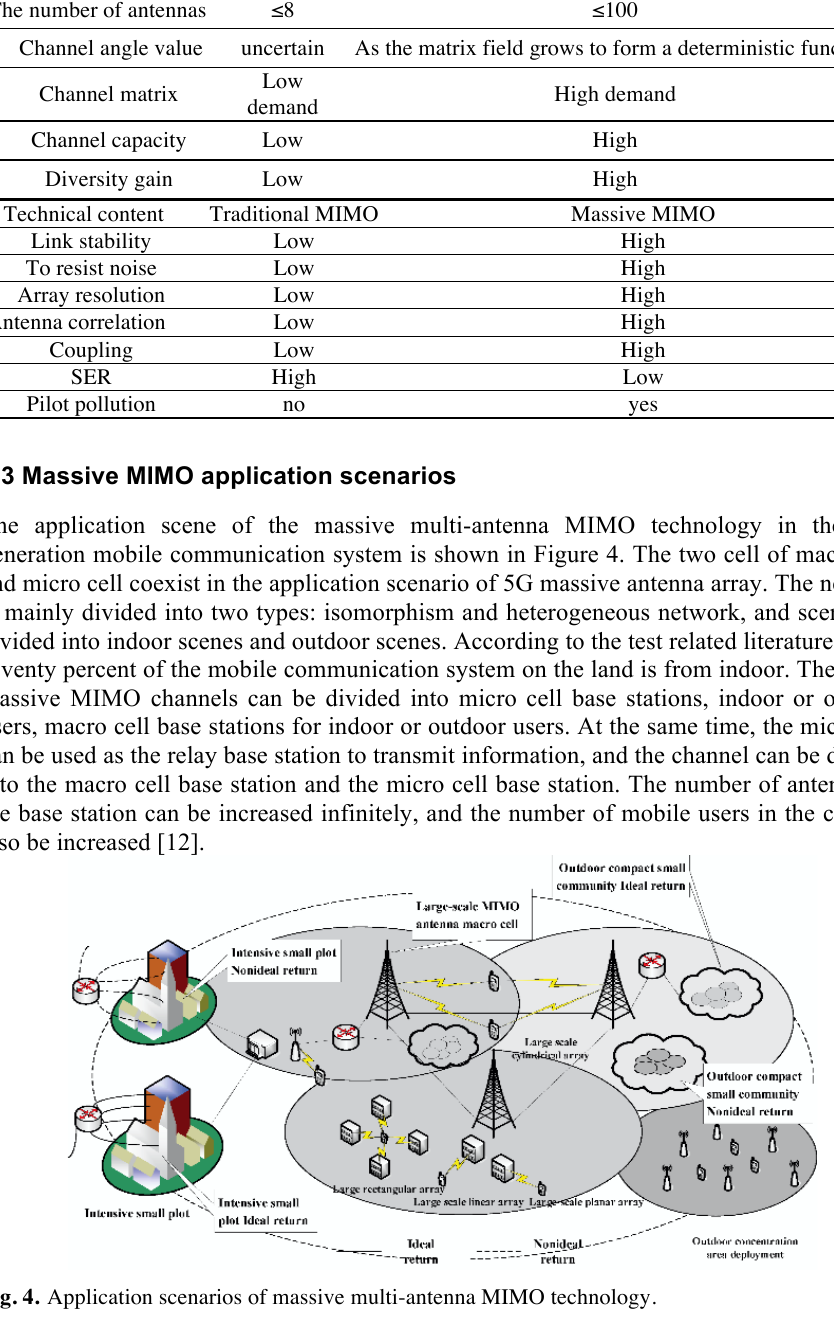
Table 2. Traditional MIMO and massive MIMO performance comparison